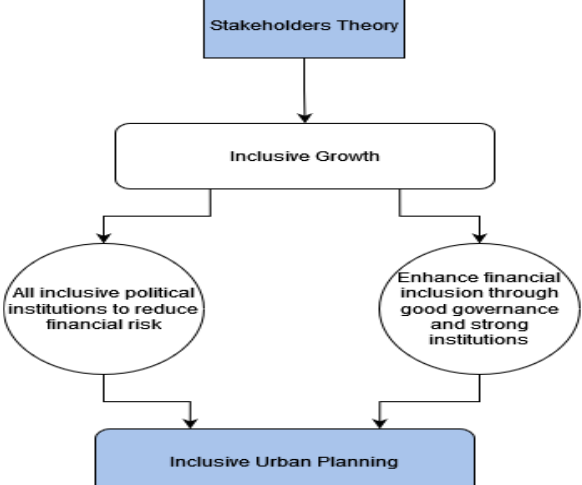
Figure 4. The figure proposed a conceptual framework for inclusive growth for countries. Source: Author’s